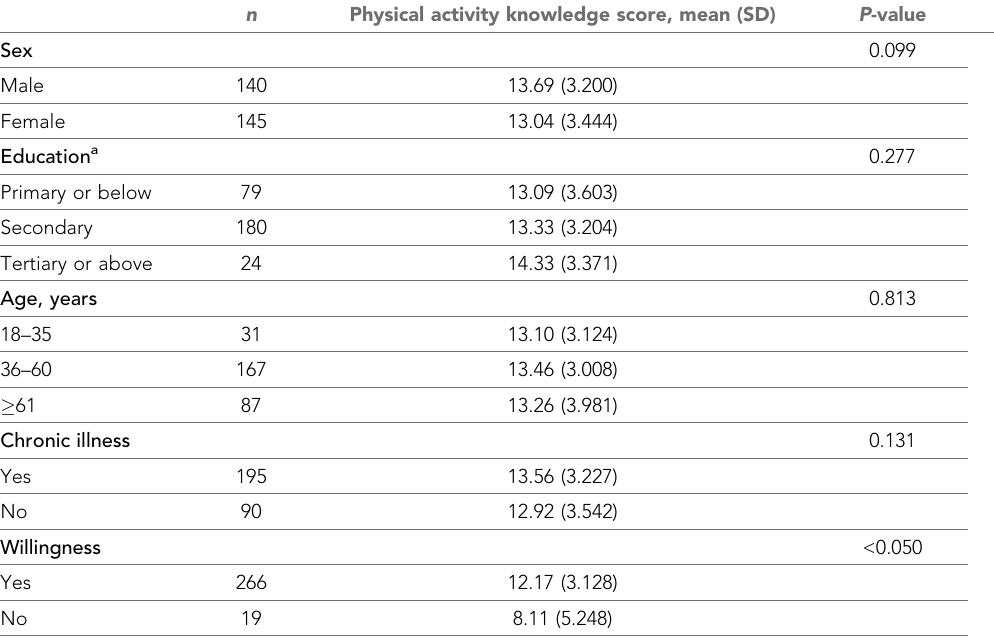
Table 5. PA knowledge score according to different demographic, disease factors and